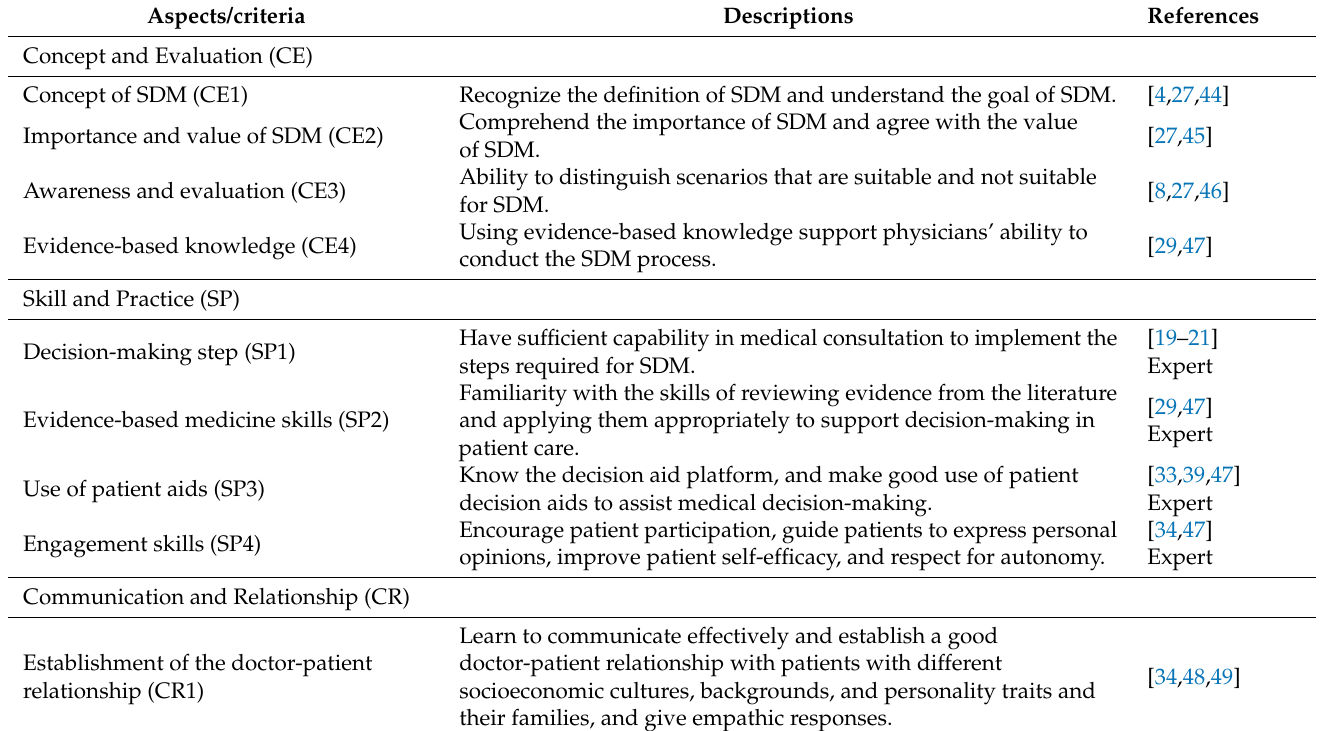
Table 1. The definitions of aspects/criteria for competency evaluation of SDM